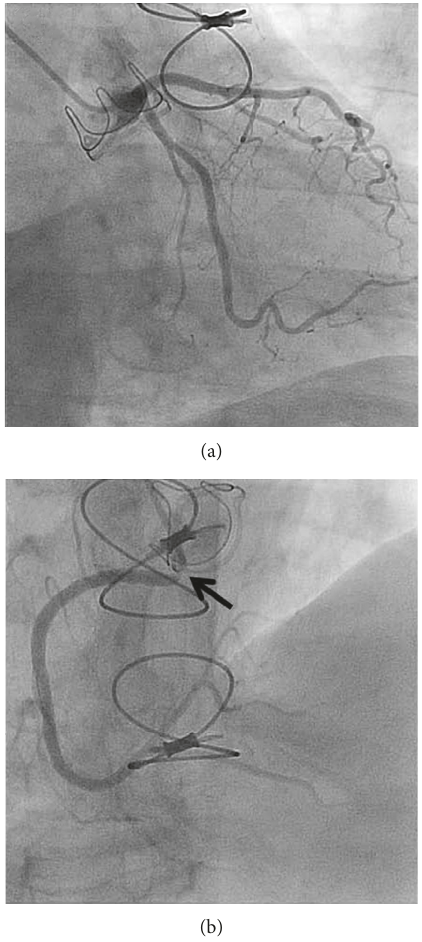
Figure 2: Diagnostic coronary angiogram shows (a) widely patent left coronary arteries and (b) severe ostial stenosis of the right coronary artery (arrow).